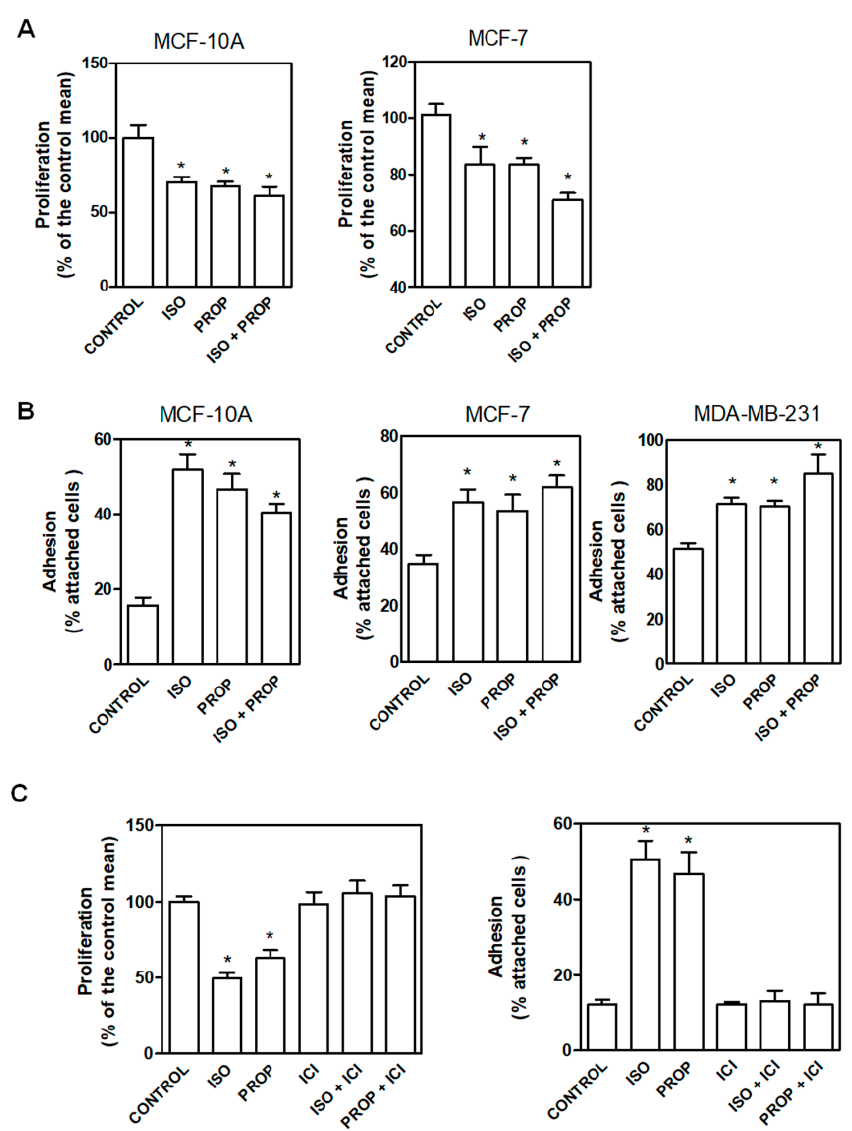
Figure 1. E ff ect of isoproterenol (ISO, 1 µ M)) and propranolol (PROP, 1 µ M) on cell proliferation and cell adhesion of tumor and non-tumor breast cells. ( A ) Cells were incubated with ISO, PROP or both and cell proliferation was measured in MCF-10A and MCF-7 cells. ( B ) E ff ect of ISO and / or PROP on cell adhesion of MCF-10, MCF-7 and MDA-MB-231 cells. ( C ) E ff ect of a β 2-AR selective antagonist ICI-118551 (ICI, 10 µ M) on ISO or PROP e ff ect on MCF-10A cell proliferation or cell